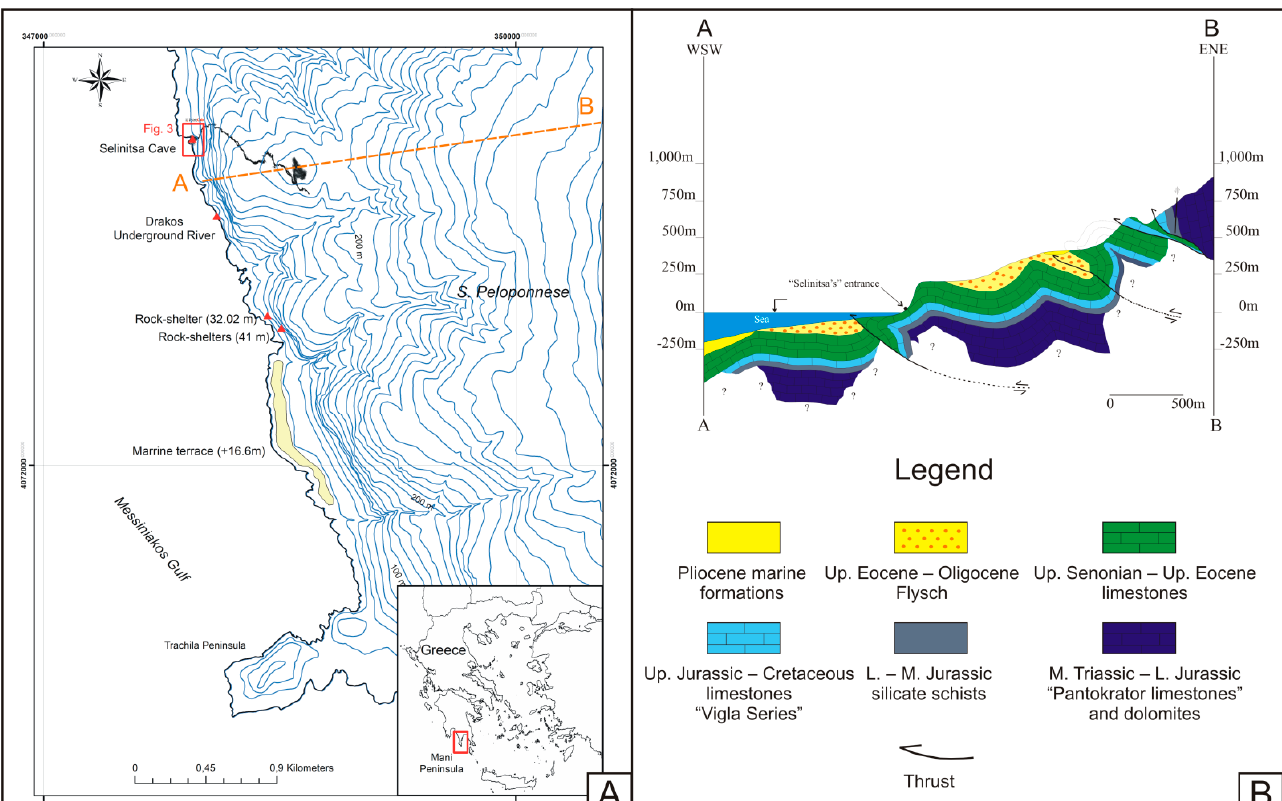
Figure 1. ( A ). Map of the studied area in SW Peloponnese. Blue contour lines represent surficial topography. Red triangles depict the location of geomorphological landforms discussed in the text, and the yellow area represent the surficial extent of the marine terrace at 16.6 m asl. ( B ). Geological depiction of the entrance and host lithologies of Selinitsa Cave.